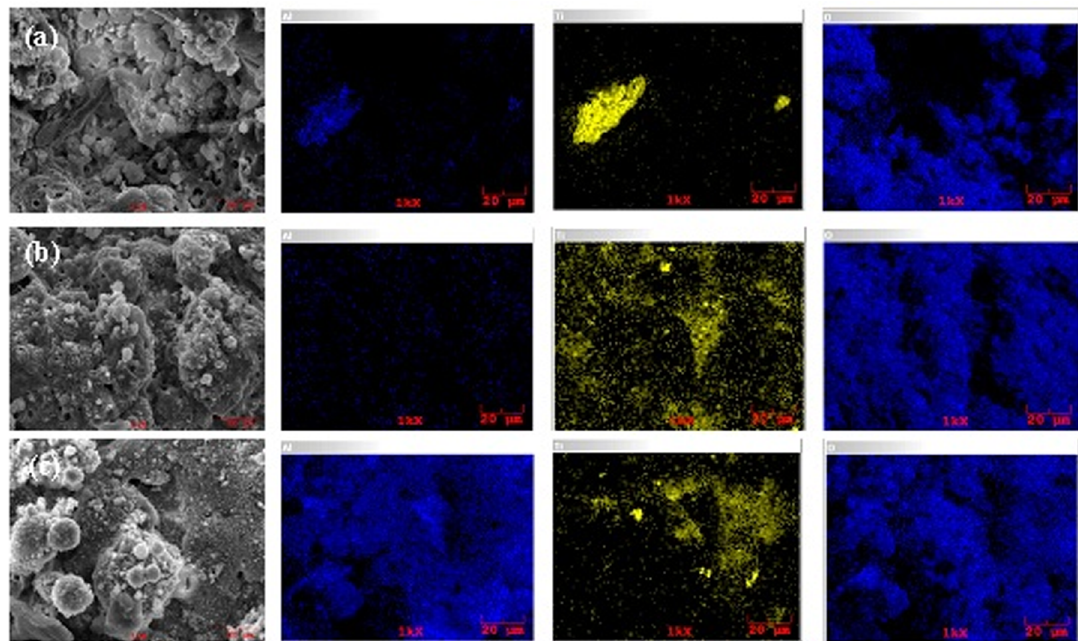
, (c) MAO-Al O 2 2 3